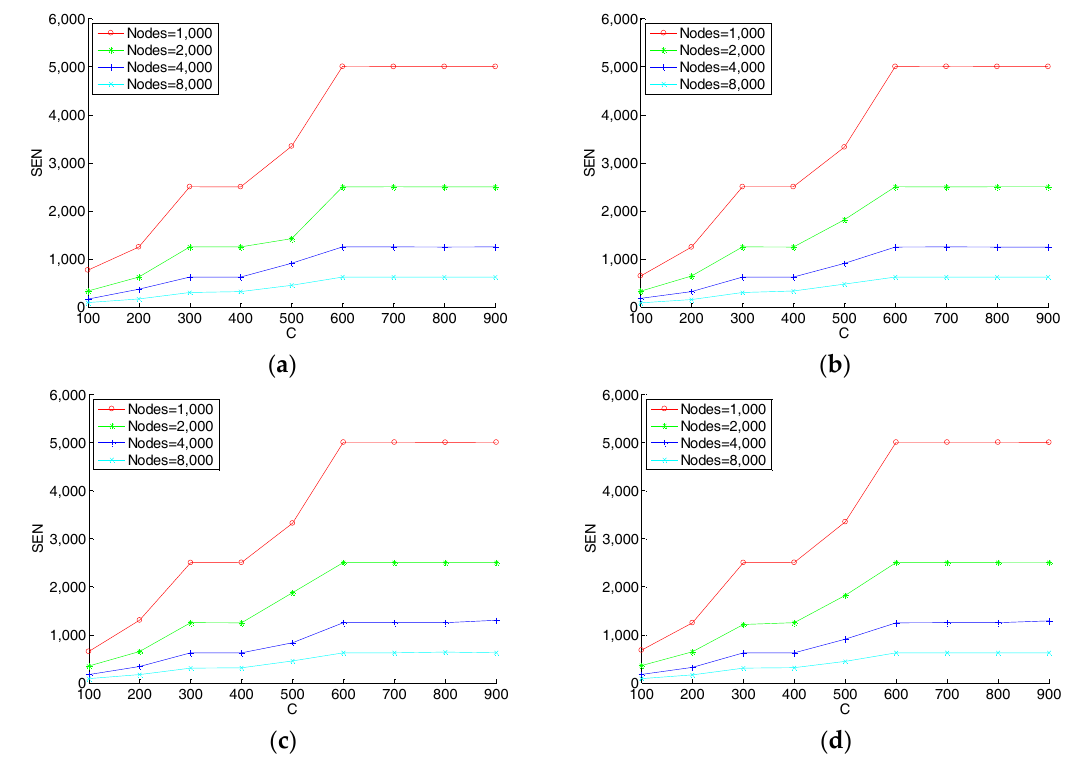
Figure 7. The average storage in each node, ( a ) N = 1, ( b ) N = 2, ( c ) N = 3, and ( d ) N = 4.